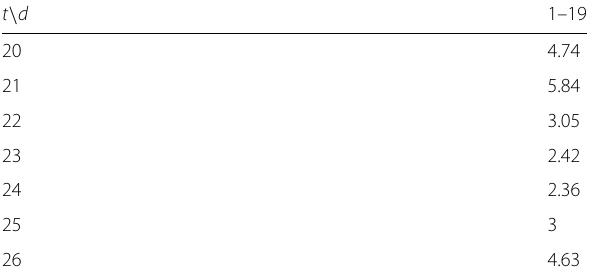
Table 11 Estimated values of the variance of the error distributions for the same-day demand